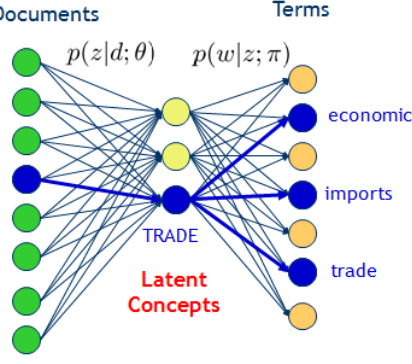
Fig. 1: Schematic representation of PLSA general structure. It shows the latent topics that links documents and words into common topics with the associated probabilities. Source: